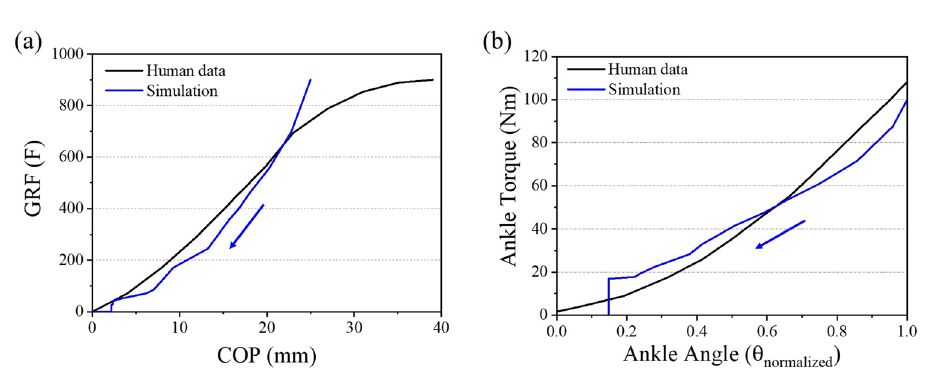
Figure 11. The objective functions (maximum stress, ( R the bending zone (radius 1 and radius 2).